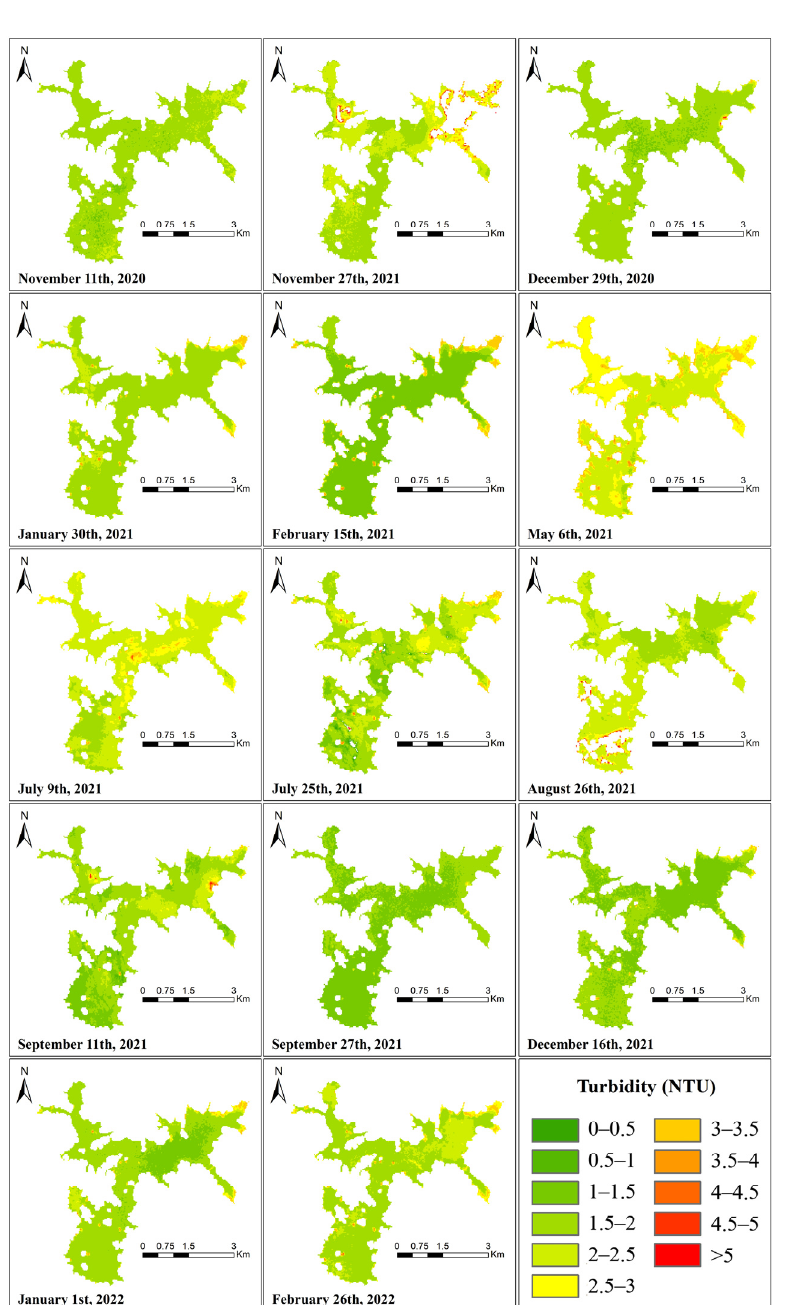
Figure 10. Spatial distribution of turbidity from Landsat OLI data.